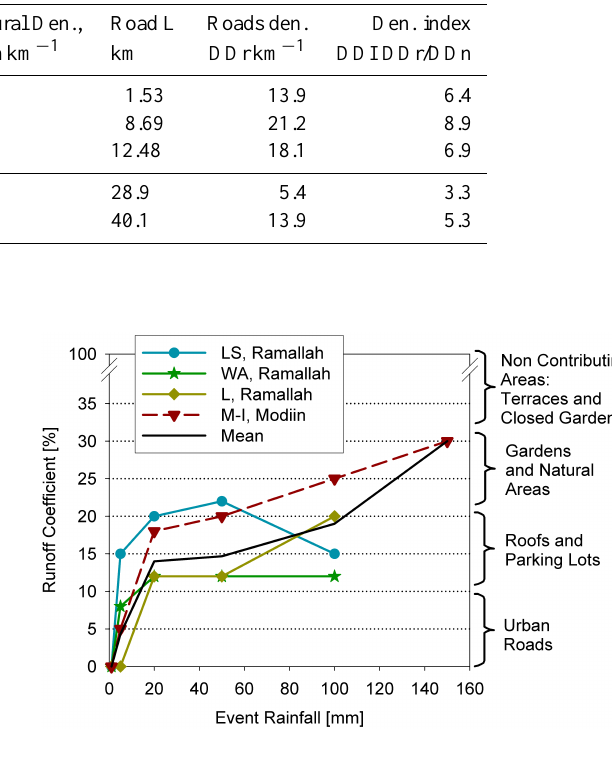
Fig. 11. Conceptual model for sequential runoff generation inside the two